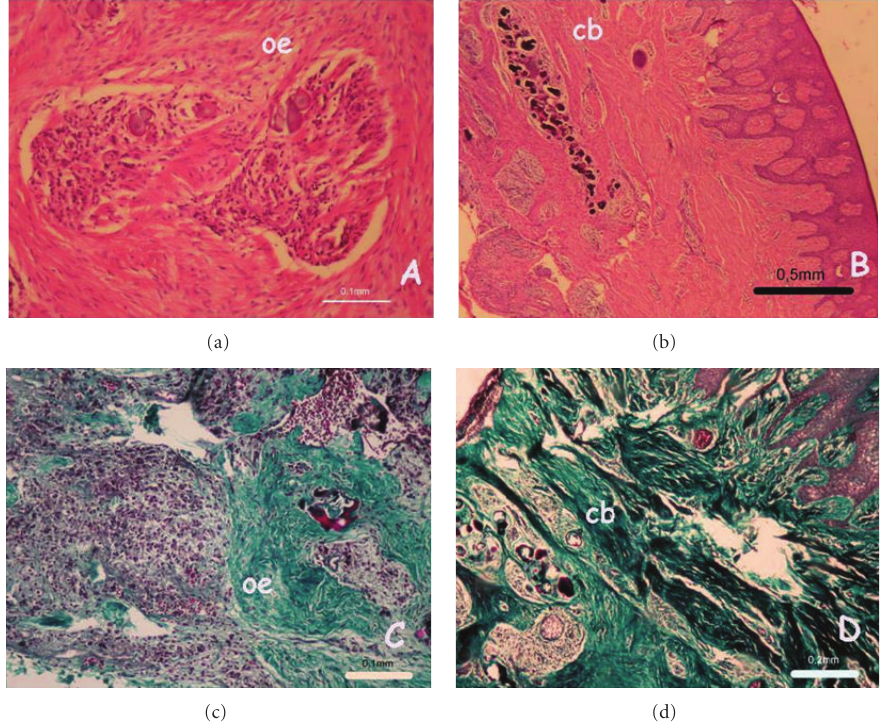
Figure 4: Odontogenic epithelium (oe), and calcified bodies (cb) were seen in hematoxylin and eosin ((a) and (b)) and Masson’s trichrome ((c) and (d)) stainings of younger ((a) and (c)) and older ((b) and (d))